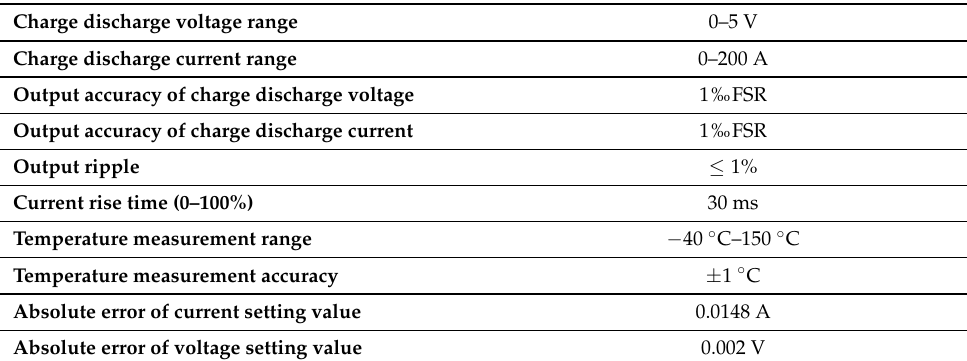
Table 4. Parameters and error values of the battery test